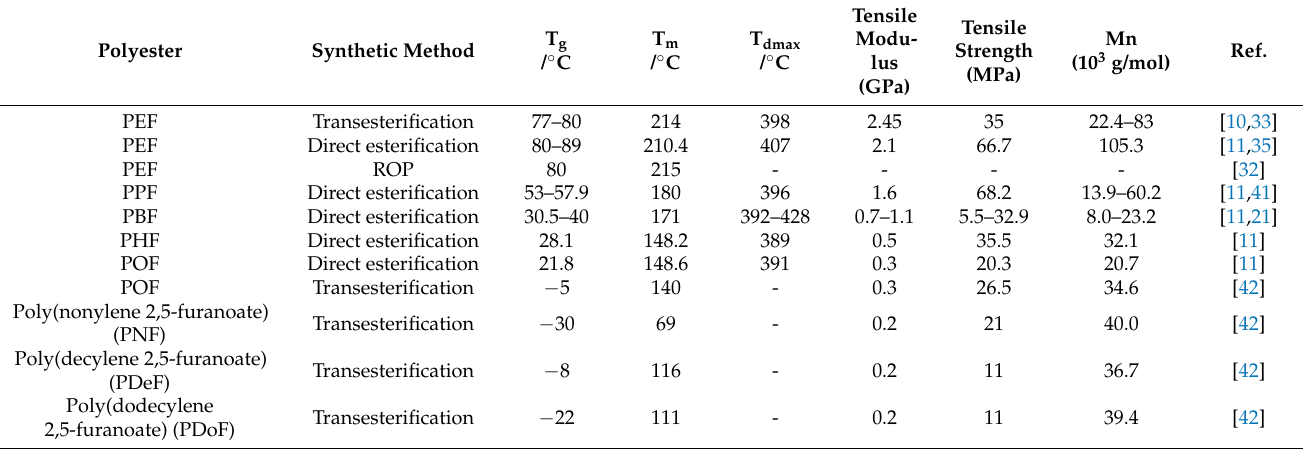
Table 1. Thermal and mechanical properties of furan-polyesters with aliphatic diols via different synthetic methods.